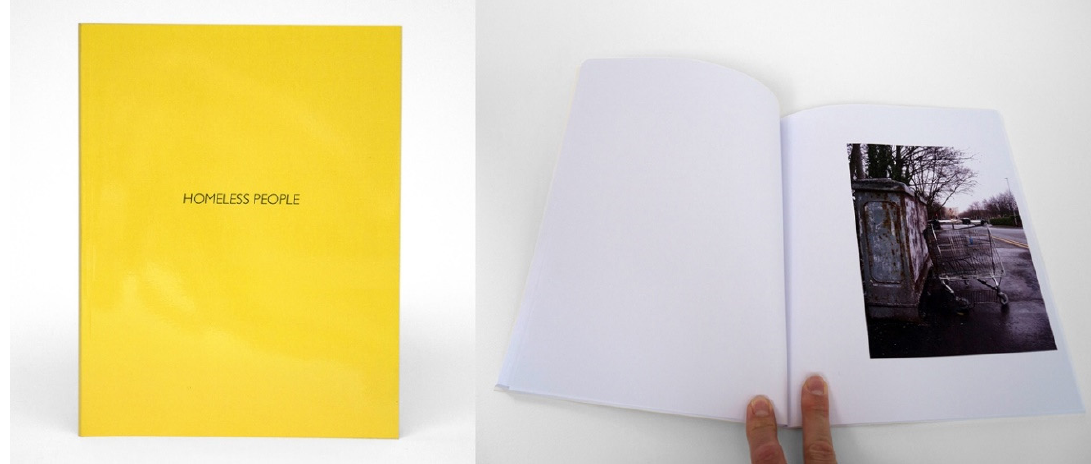
Figure 31. Tom Sowden, Homeless People , 2004.